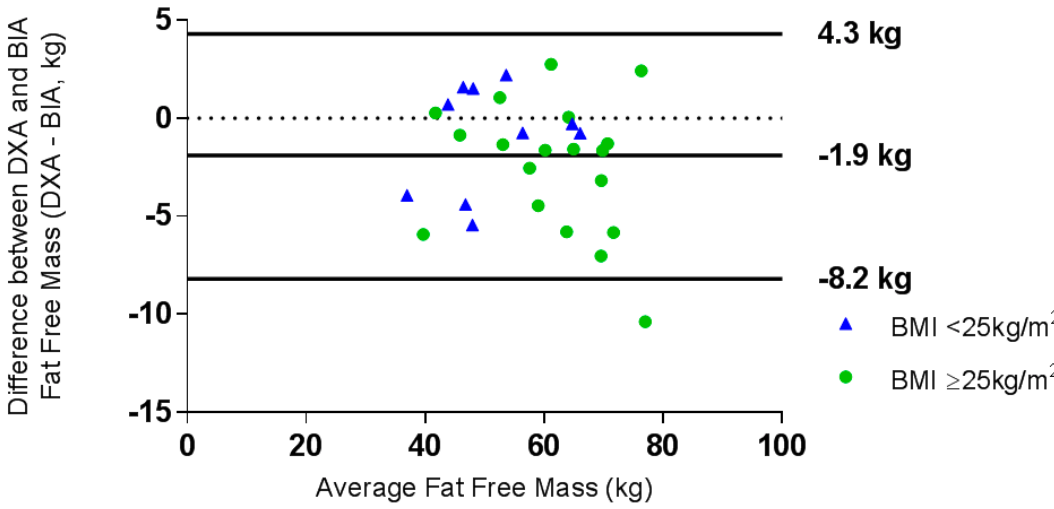
Figure 2. Bland-Altman plot of the difference between fat-free mass (kg), as measured by DXA and BIA, against the mean fat-free mass (kg) for the whole group. ● BMI ≥ 25kg/m 2 , BMI < 25kg/m 2 .